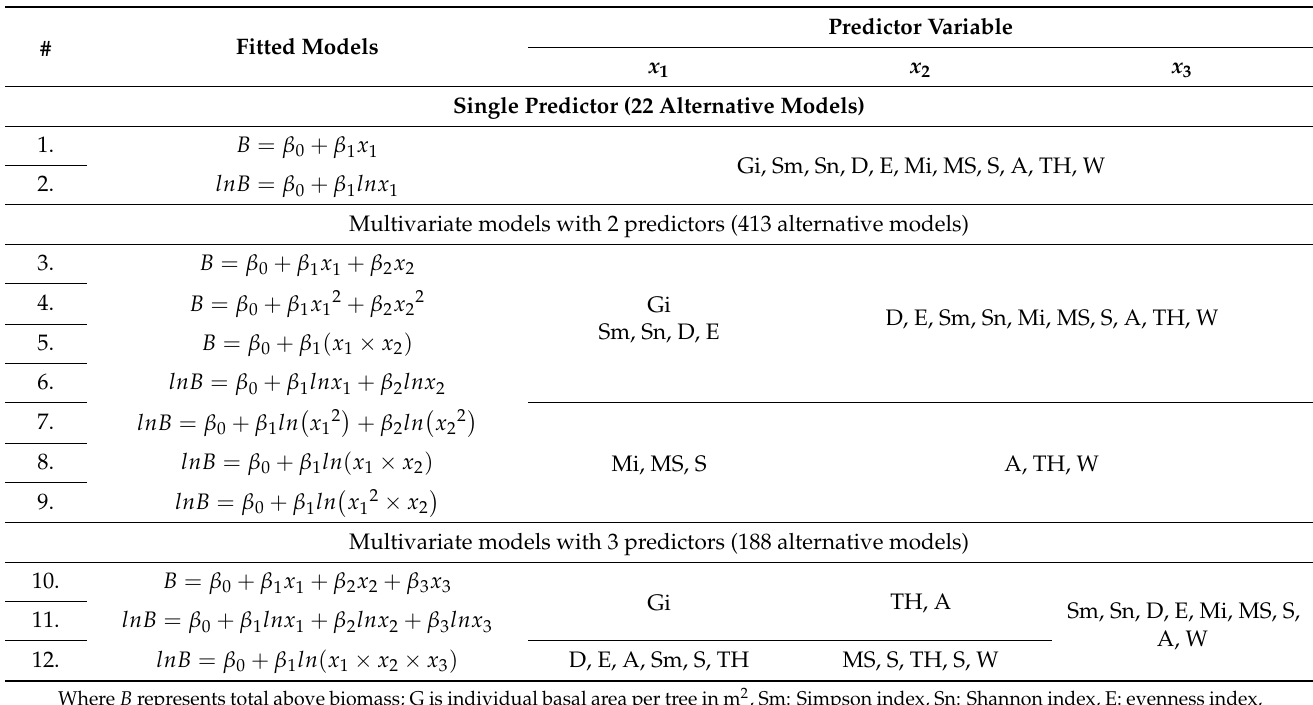
Table 3. Models tested including its general structure and the predictor